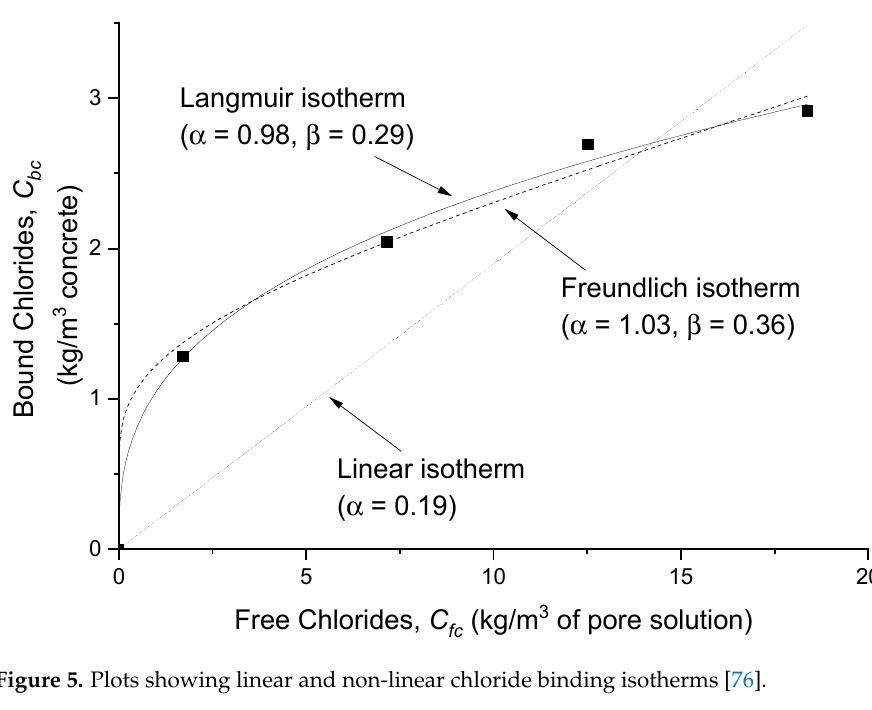
Figure 5. Plots showing linear and non-linear chloride binding isotherms [76].